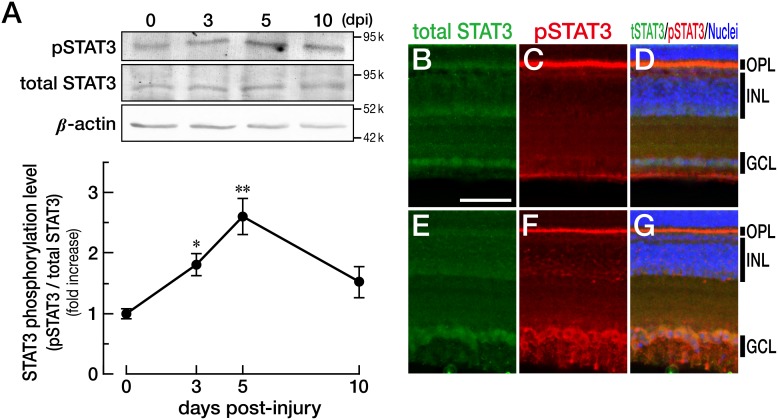
Activation of STAT3 in zebrafish RGCs after optic nerve injury.STAT3 is activated when its Tyr708 is phosphorylated (pSTAT3). (A) Western blotting of pSTAT3 revealed the activation of STAT3 at 3–5 dpi (n = 3, *p<0.05, **p<0.001). The total amount of STAT3 was not changed. (B–G) Immunohistochemical staining of total STAT3 and pSTAT3. Immunoreactivity corresponding to pSTAT3 in RGCs was drastically increased at 5 dpi (F) compared to the intact retina (C), whereas total STAT3 remained unchanged (B: intact, E: 5 dpi). (D) and (G) show merged images of (B, C) and (E, F), respectively, with nuclear staining for orientation. The scale bar in (B) is 50 µm. OPL: outer plexiform layer.